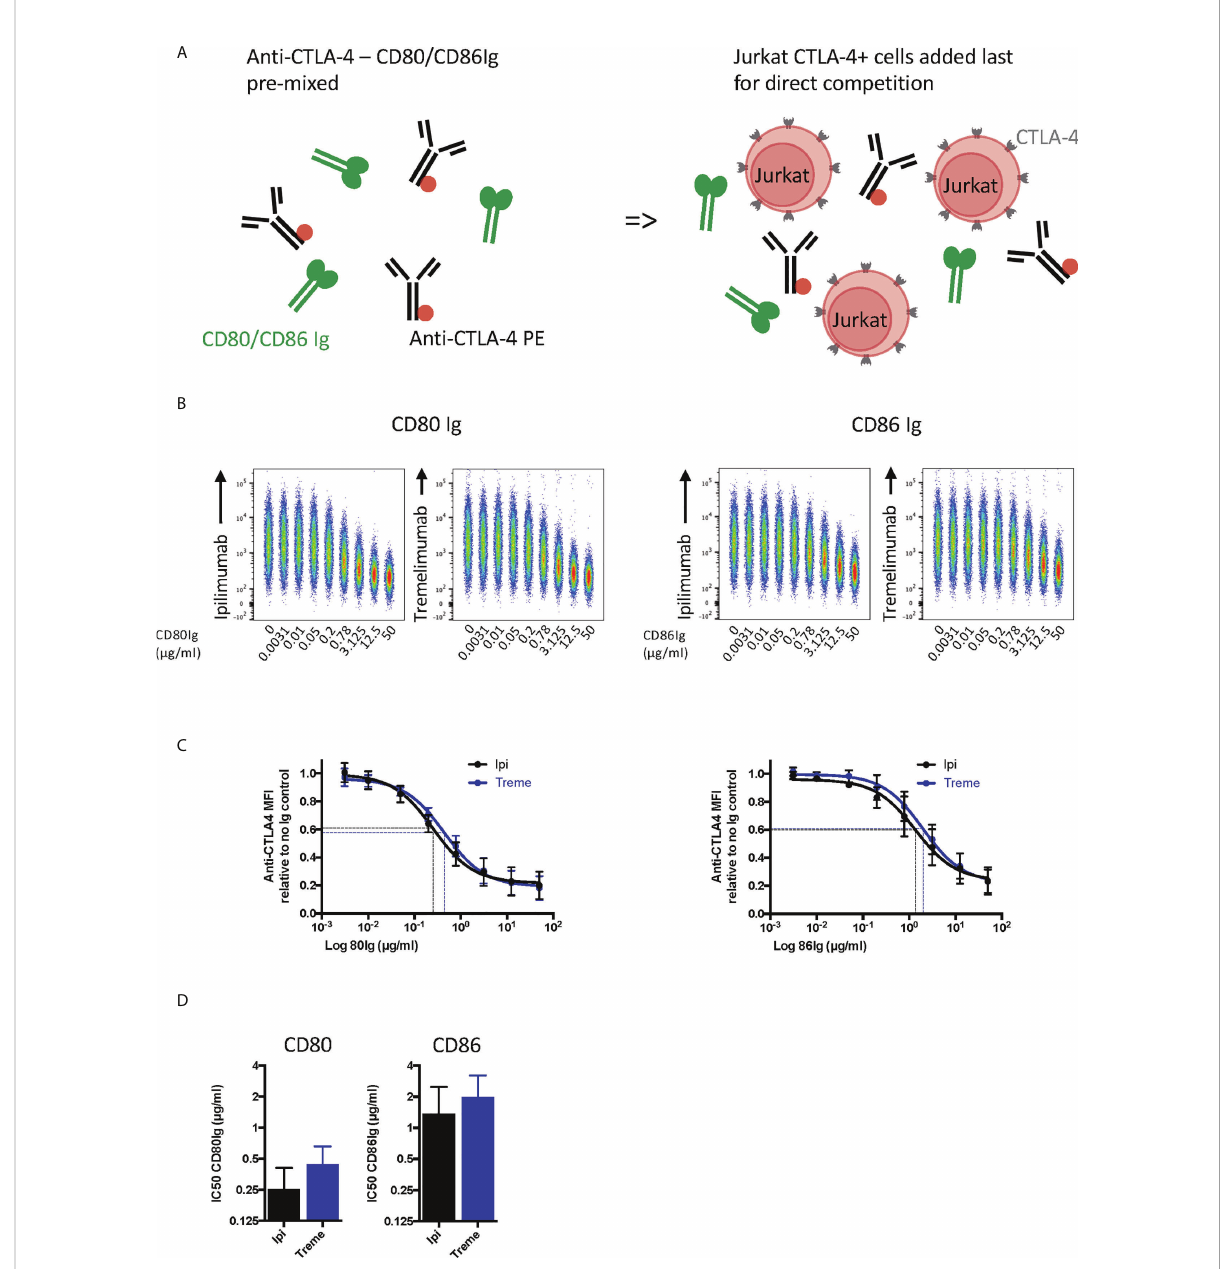
FIGURE 5 Soluble CD80 and CD86Ig outcompete Ipilimumab and Tremelimumab for engagement with cell bound CTLA4. (A) Schematic of experimental set-up. A fi xed dose (2µg/ml) of soluble PE conjugated anti-CTLA4 Abs was pre-incubated with a titration of either soluble CD80 or CD86Ig on ice. Jurkat expressing CTLA-4 cells were added to facilitate direct competition between anti-CTLA4 Abs and CD80 or CD86Ig for cell bound CTLA-4 occupancy. Cells were incubated on ice, washed and anti-CTLA4-CTLA4 engagement analysed by fl ow cytometry. All reagents/cells were chilled on ice before use. (B) Concatenated FACS plots show reduced anti-CTLA-4-CTLA-4 engagement as the dose of CD80 or CD86Ig was increased. (C) CD80 or CD86Ig doses were Log(x) transformed and dose response curves fi tted using Prism v6 to obtain Log IC 50 for ipilimumab (Black line) and tremelimumab (Blue line). (D) Graphs show the mean IC 50 with 95% con fi dence interval calculated using Prism v6. Data for ipilimumab and tremelimumab were acquired in separate 96-well plates